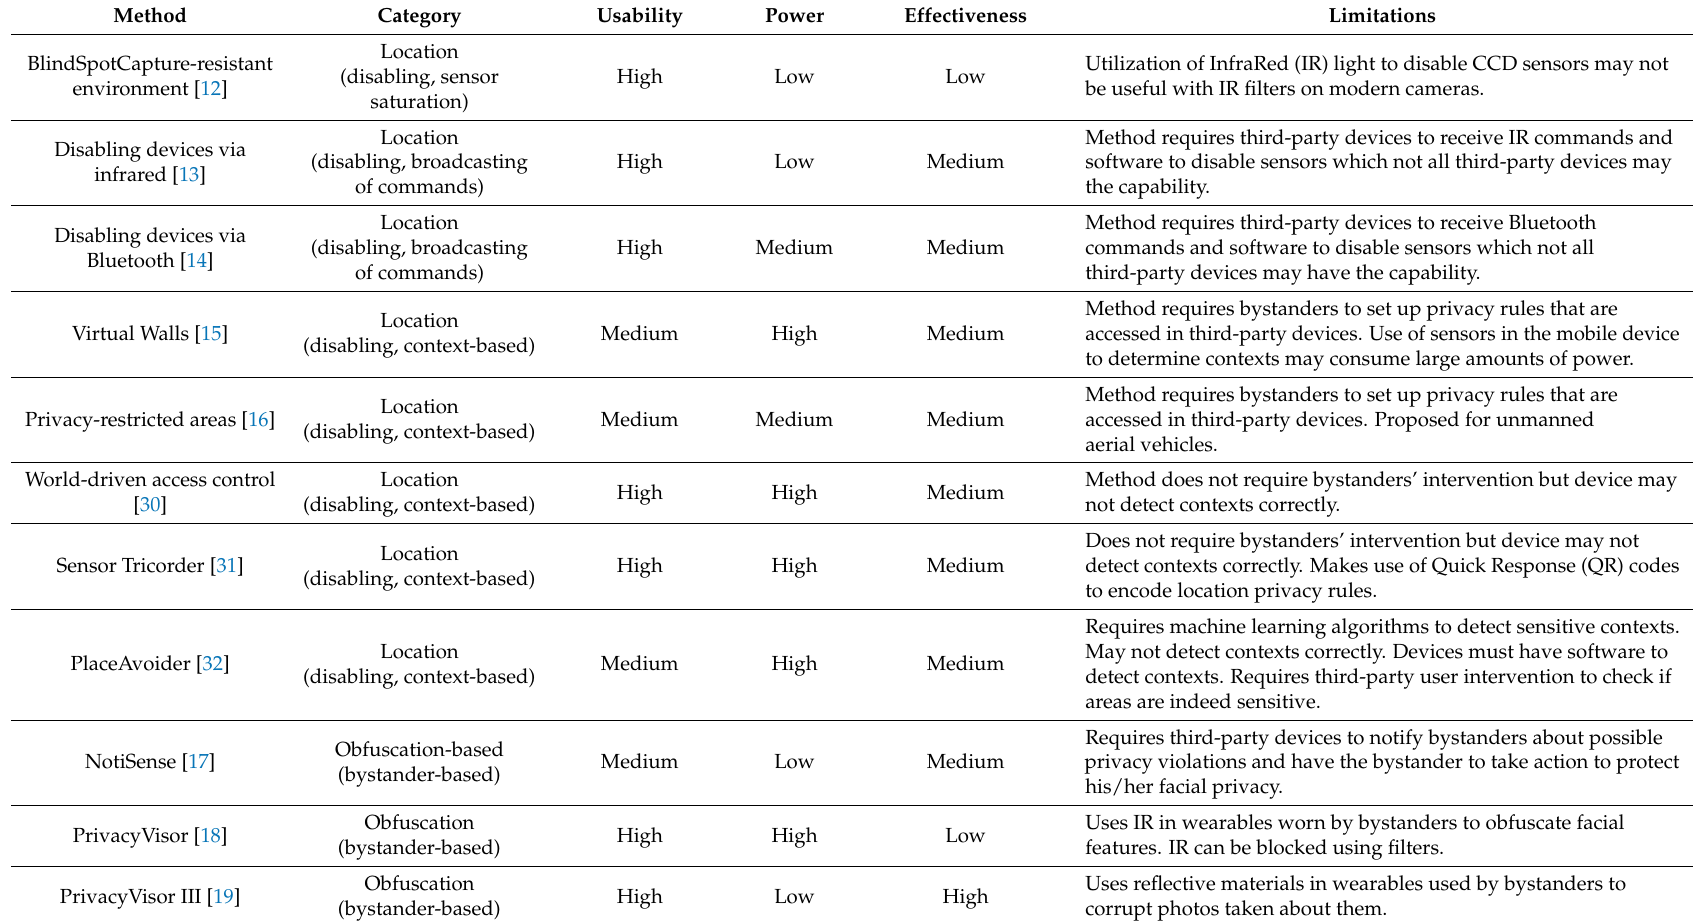
Table 3. Methods for bystanders’ facial privacy